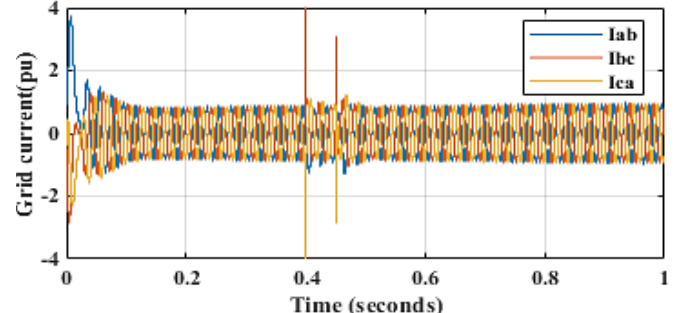
Figure 22. Grid voltage of the DFIG system under scenario III.